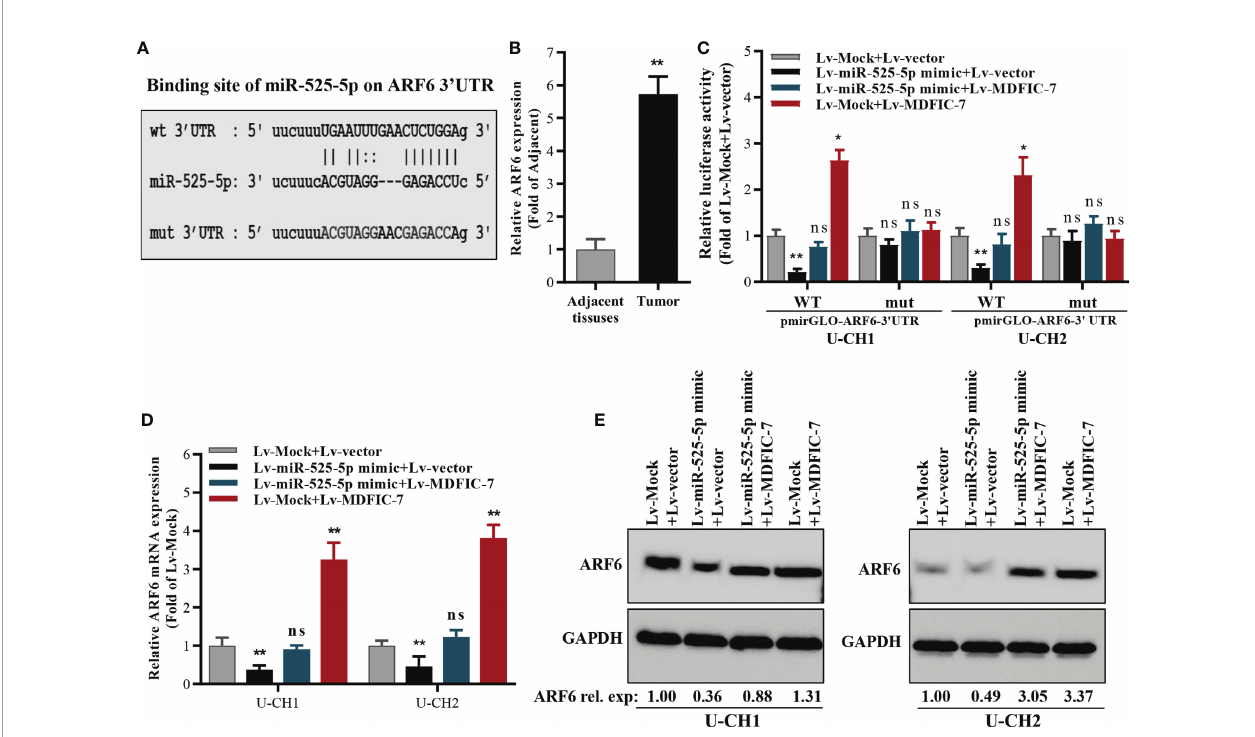
FIGURE 4 | ARF6 is a target of miR-525-5p and is regulated by the interaction of lncRNA MDFIC-7 and miR-525-5p. (A) Predicted binding site of miR-525-5p in the ARF mRNA 3 ′ UTR. (B) qRT-PCR analysis of ARF6 mRNA expression in chordoma tissues. ** p < 0.01 vs . adjacent non-tumor tissues. (C) Dual luciferase reporter assay in chordoma cells transfected with pmirGLO-ARF6 3 ′ UTR-wild type or pmirGLO-ARF6 3 ′ UTR-mut type reporter plasmids and infected with lentivirus expressing miR-525-5p mock, miR-525-5p mimic or MDFIC-7 as indicated. * p < 0.05 vs . Lv-mock+Lv-Vector, ** p < 0.01 vs . Lv-mock+Lv-Vector, ns, no signi fi cant differences vs . Lv-mock+Lv-vector. (D) qRT-PCR analysis of ARF6 mRNA expression in cancer cells infected with the indicated lentivirus for 48 h. ** p < 0.01 vs . Lv- mock+Lv-vector, ns, no signi fi cant differences vs . Lv-mock+Lv-vector. (E) Western blot analysis of ARF6 protein expression in cancer cells infected with the indicated lentivirus for 48